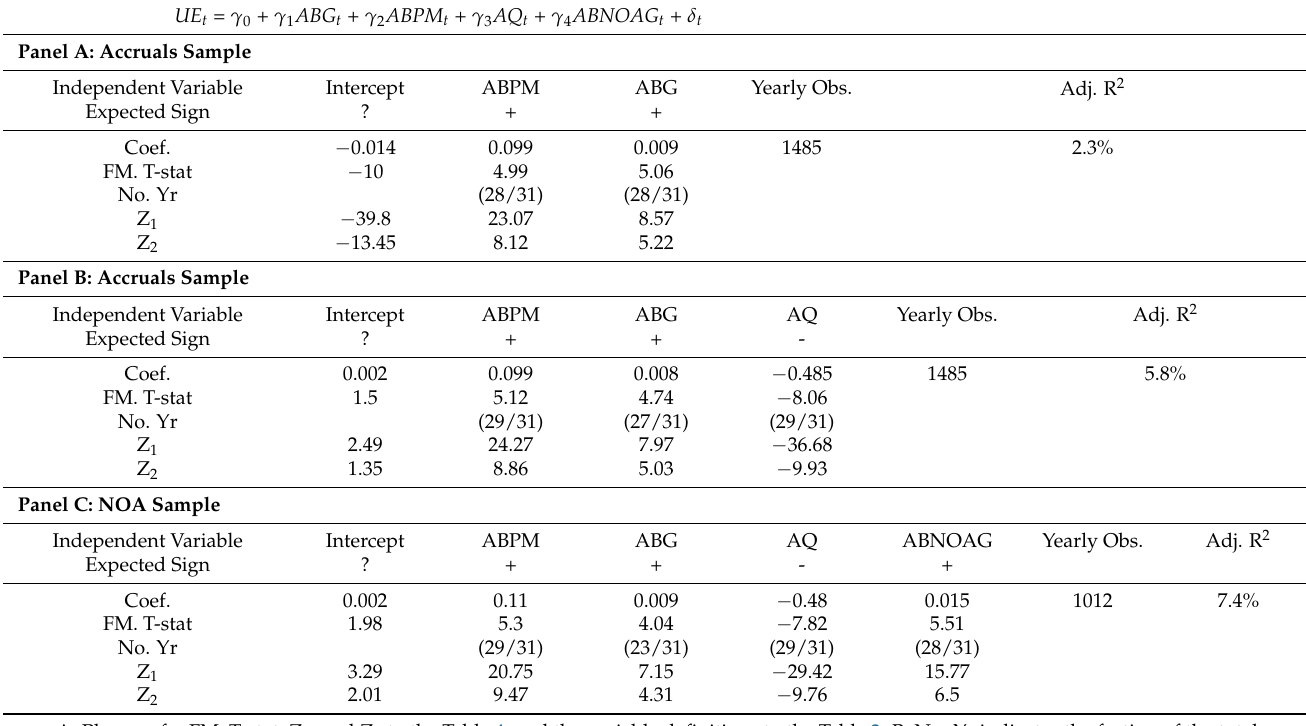
Table 5. Results of the regression of unexpected earnings (the dependent variable is unexpected